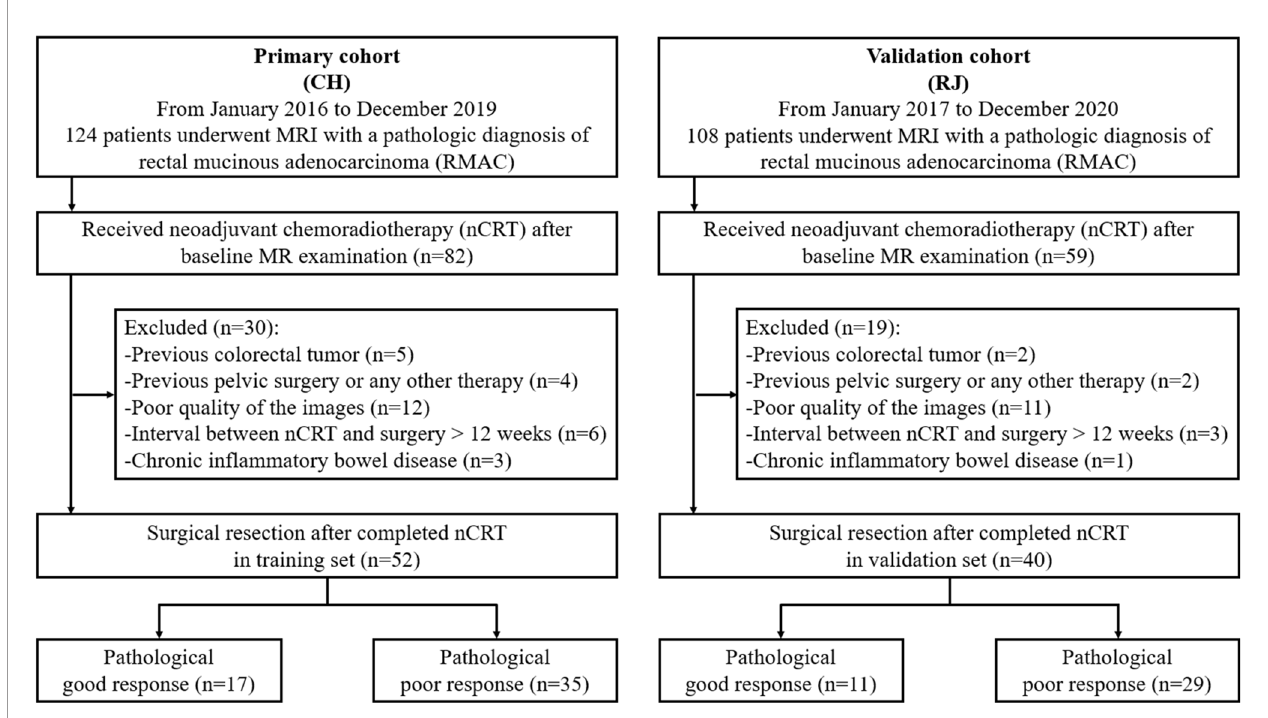
FIGURE 1 | Study fl owchart. CH, Changhai Hospital; RJ, RuiJin Hospital LuWan